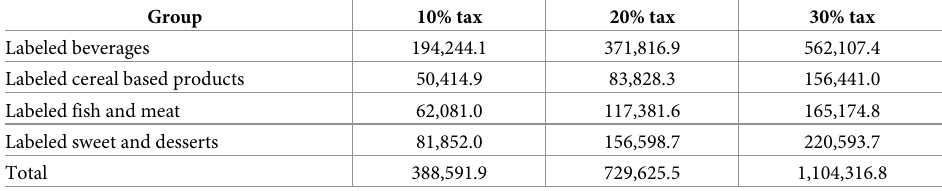
Table 3. Revenue estimations for tax scenarios on food and beverages (millions of 2019 Chilean